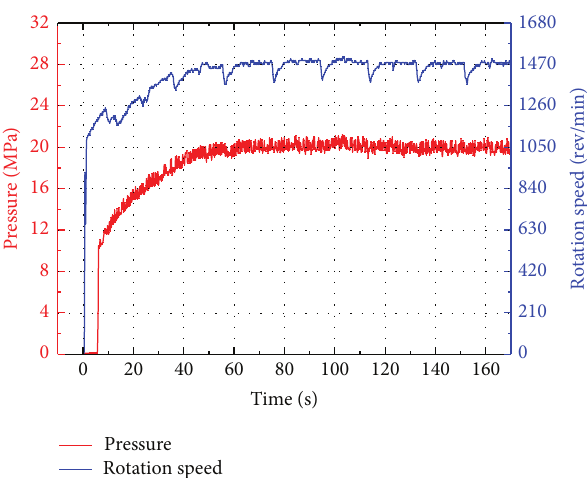
Figure 15: Experiment results of the test emulsion pump.